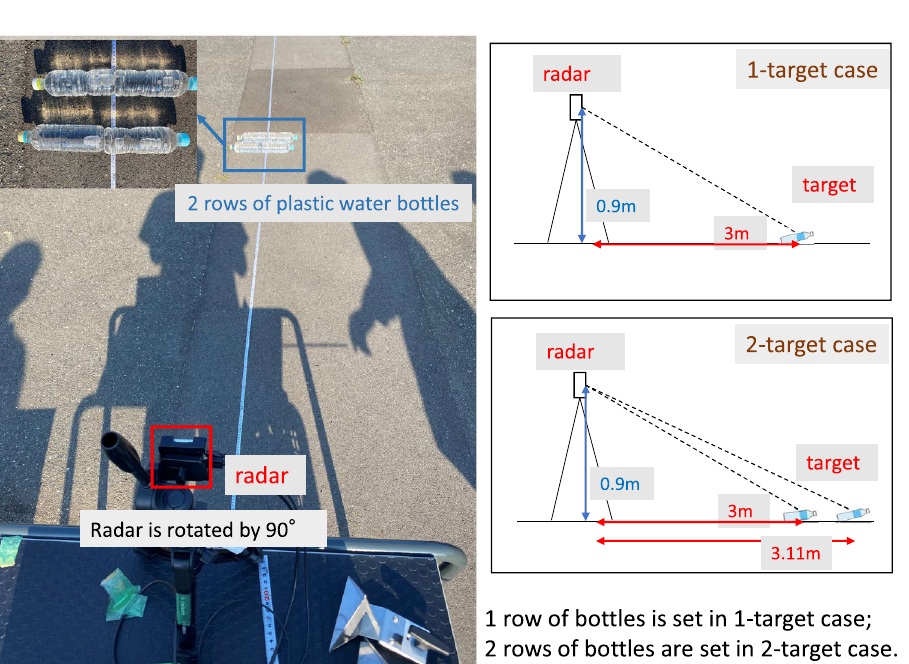
Figure 21. Demonstration environment for vertical angle estimations of on-road obstacles: plastic water